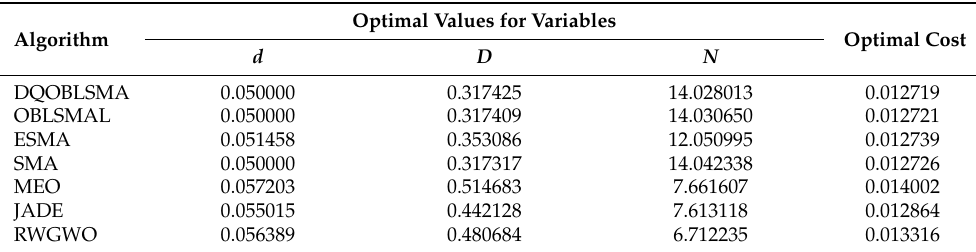
Table 12. Comparison for the tension/compression spring design